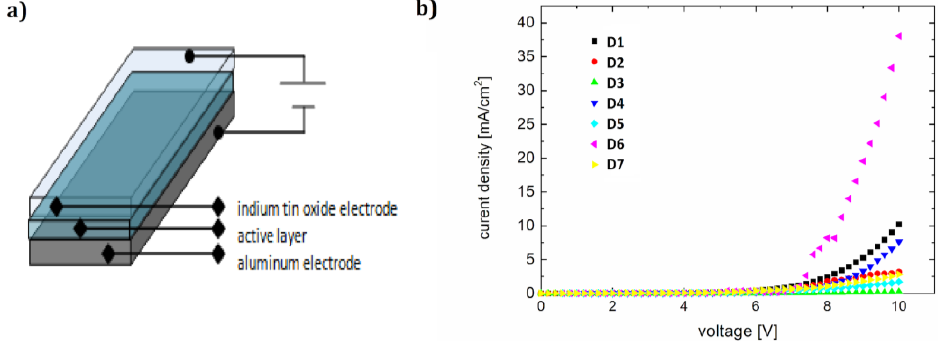
Figure 8. Device architecture ( a ) and current-voltage characteristics of diodes D1–D7 ( b ) .